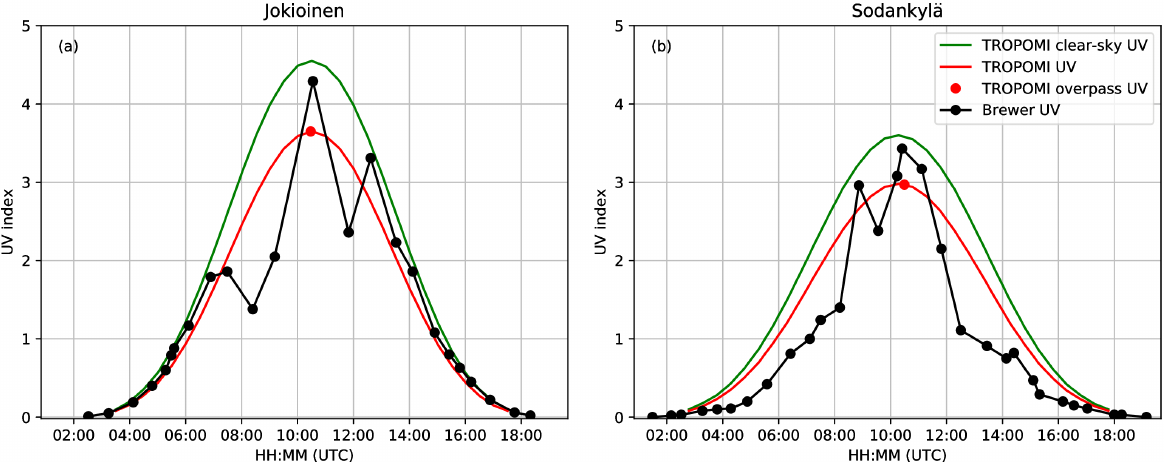
Figure 5. The UV index as measured by a Brewer spectrophotometer in (a) Jokioinen, and (b) Sodankylä on 13 August 2007 together with results from the TROPOMI UV algorithm based on OMI